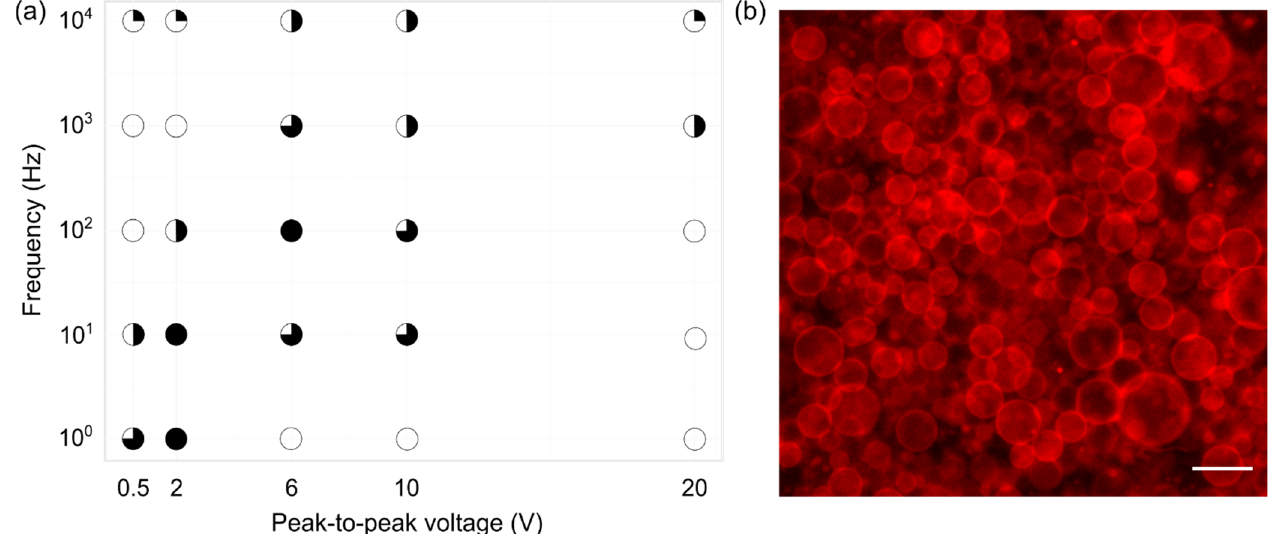
Figure 3. ( a ) Electroformation successfulness dependence on frequency–voltage combinations for a 1/1/1 POPC/SM/Chol mixture and a lipid concentration of 3.75 mg/mL. Successfulness takes into account the population homogeneity, yield, and size of GUVs, as well as the amount of defects. It is displayed here through circle fullness, where a fuller circle indicates better successfulness. Empty circles denote that no GUVs were formed or their number was negligible. ( b ) Fluorescence microscopy image of electroformed GUVs for a 10 Hz–2 V frequency–voltage combination. The scale bar in the bottom right corner denotes 50 µ